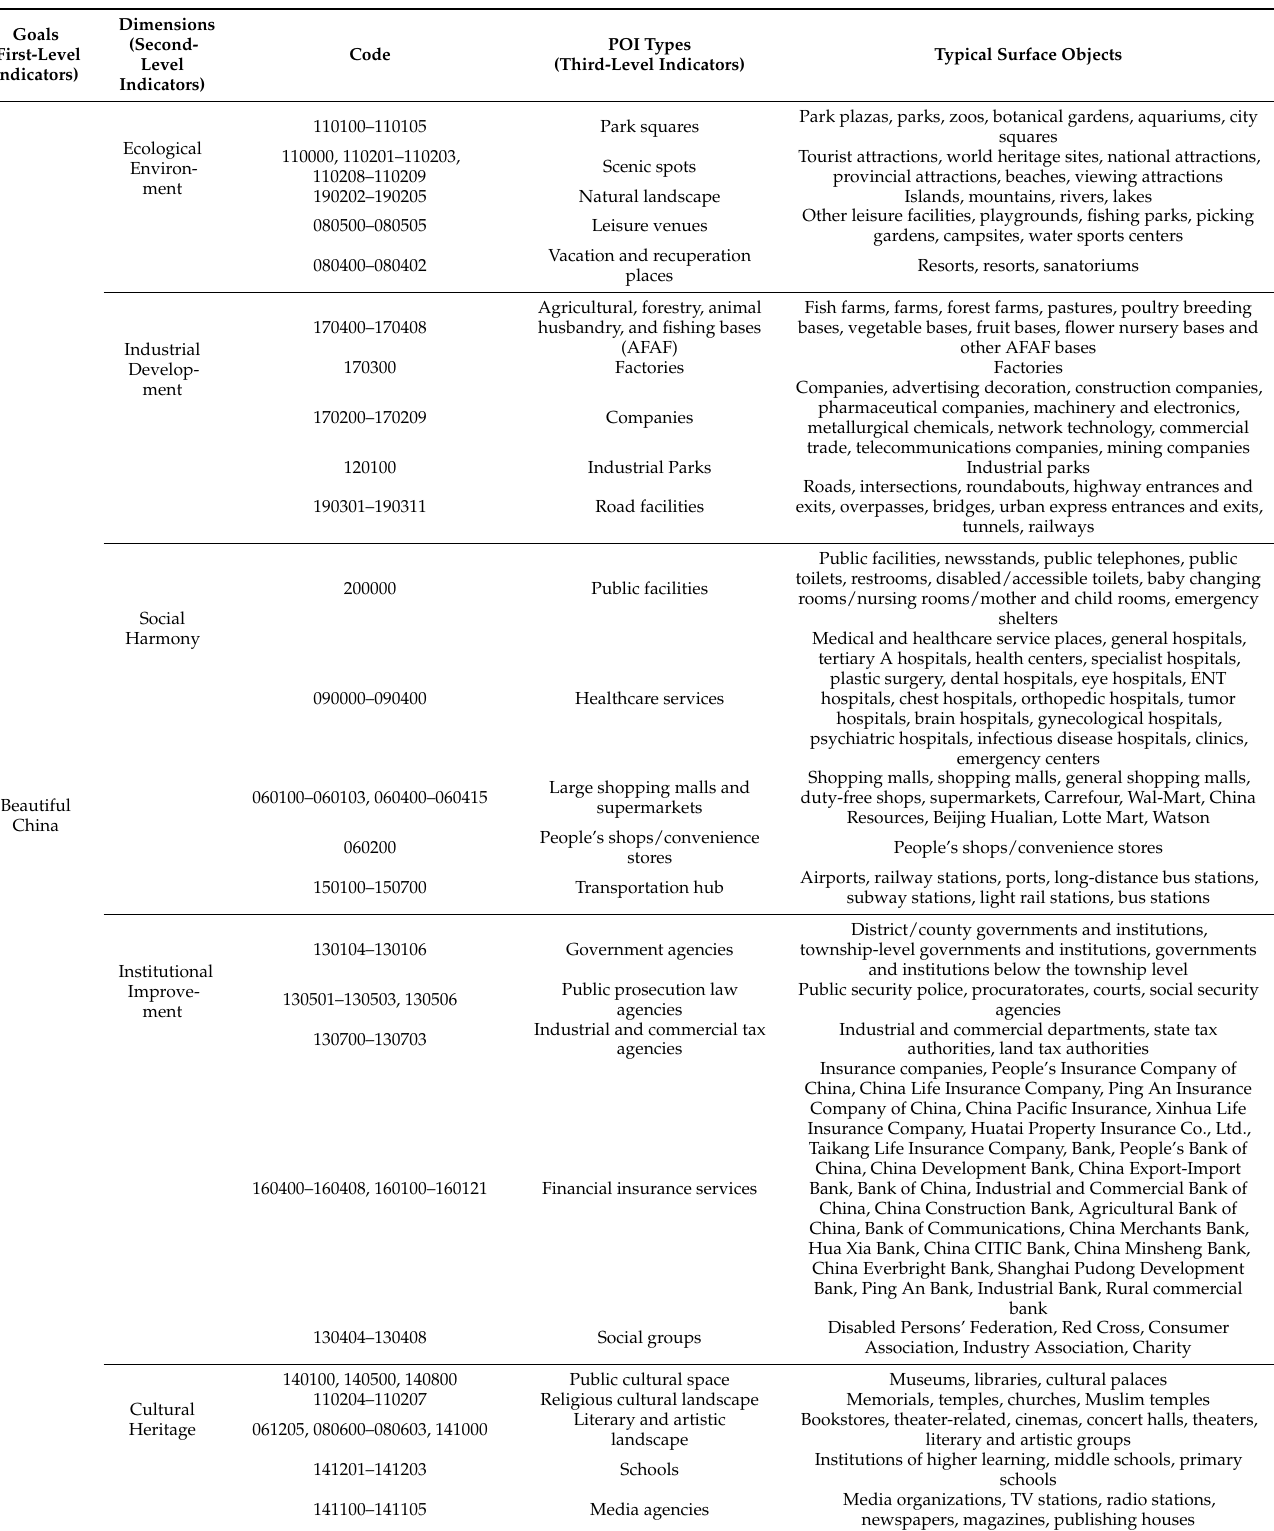
Table 1. Evaluation index system of Beautiful China